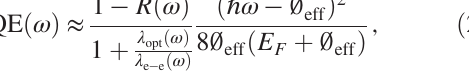
, as a function of e